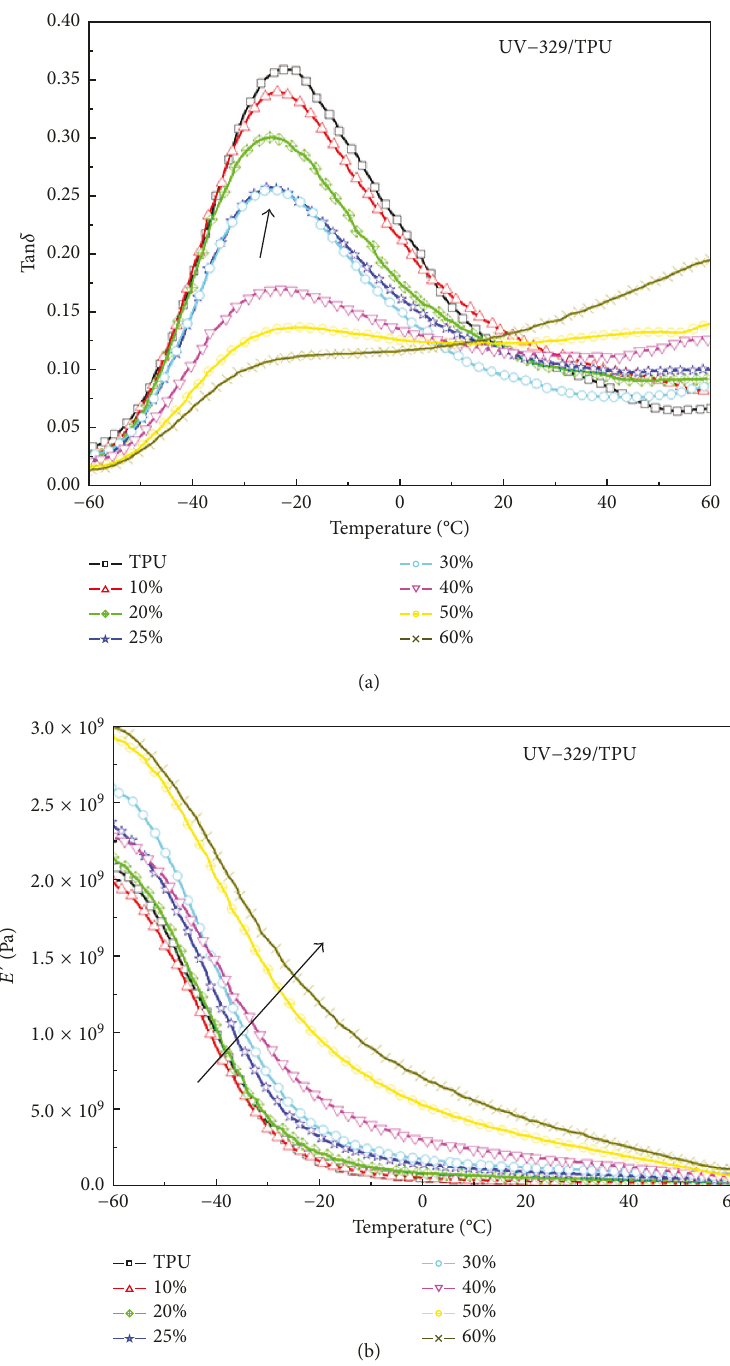
Figure 6: Temperature dependence of (a) tan δ and (b) E